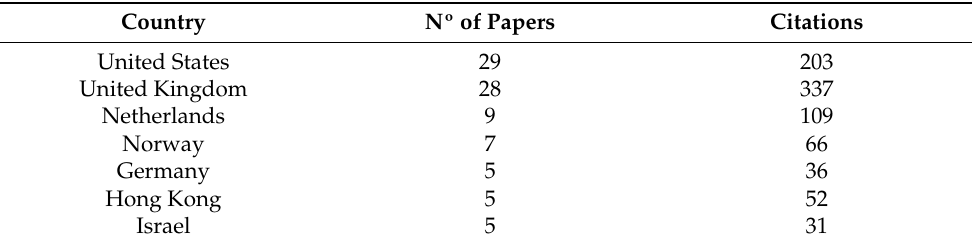
Table 1. Top seven most productive countries of the selected publications. Country Nº of Papers